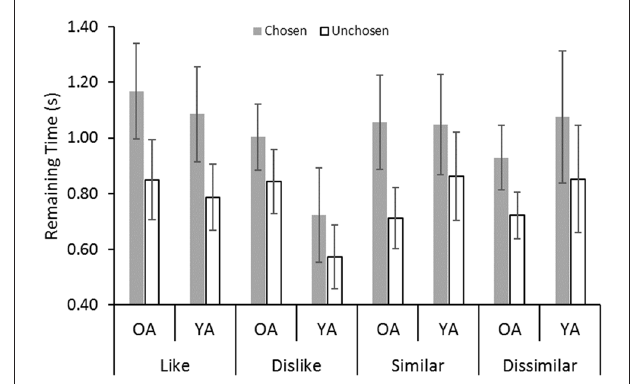
FIGURE 3 | Average dwell duration values in the first dwell time epoch: YA, younger adults; OA, older adult. Error bars represent standard errors.